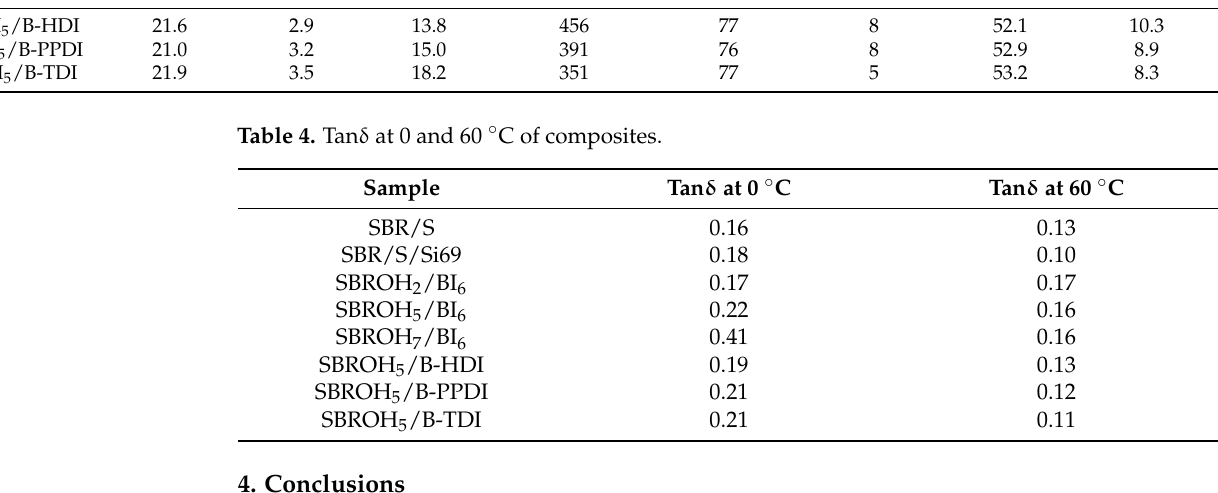
Figure 9. ( a ) stress − strain curves and ( b ) tan δ -T curves of SBROHx cured by different blocked diisocyanates. Table 3. Mechanical properties of different blocked polyisocyanates-cured SBROH 5 composites.